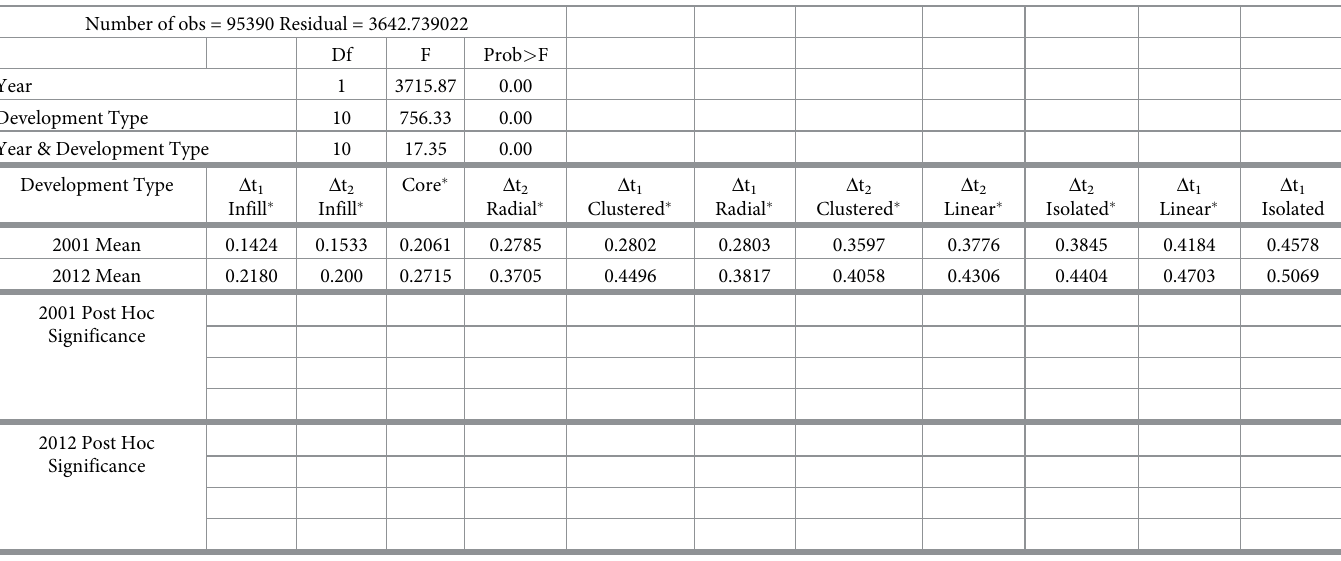
Table 5. Two-way ANOVA, and Tukey’s post hoc